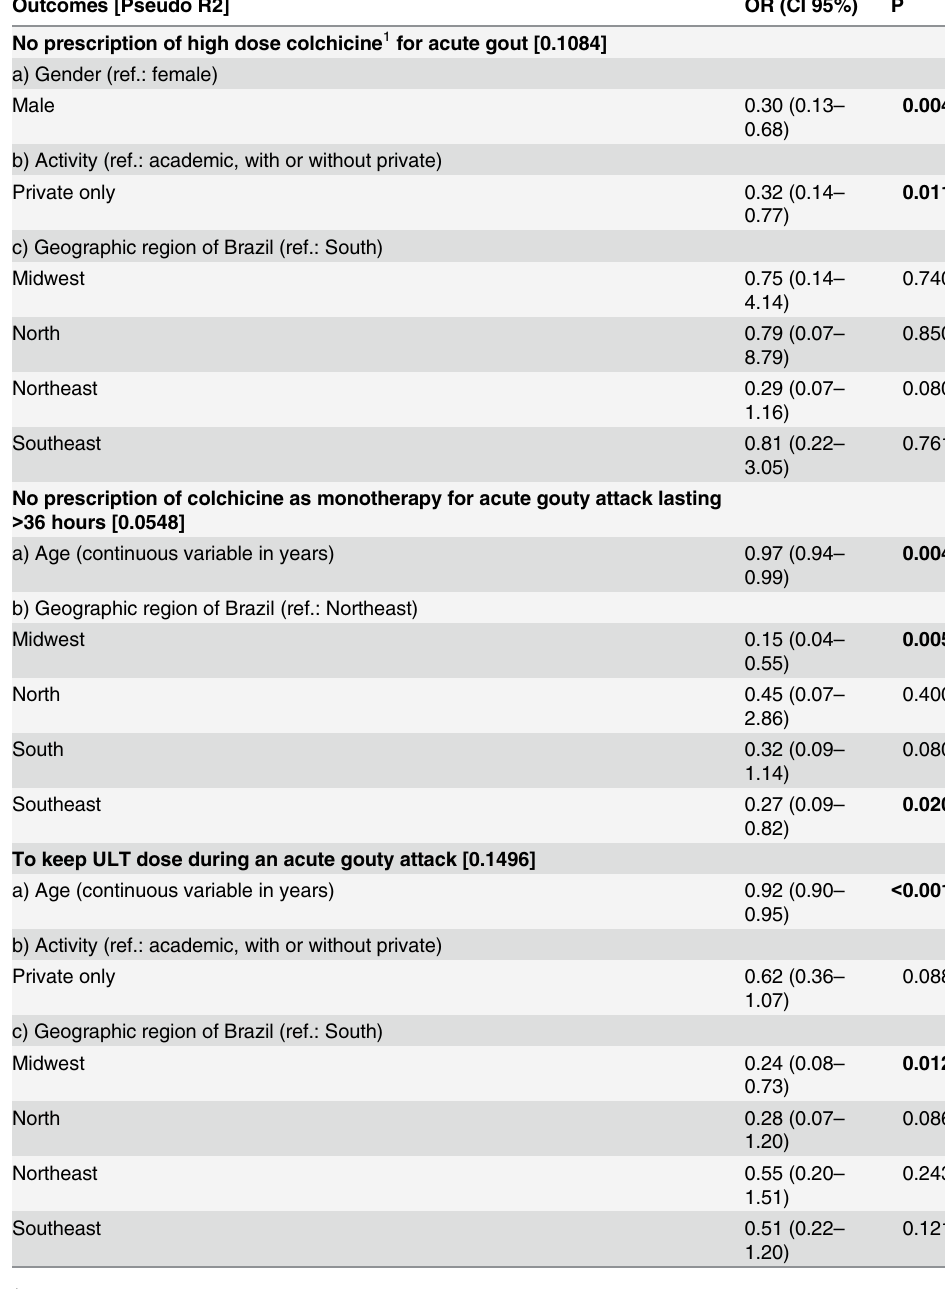
Table 4. Multivariate-adjusted predictors of concordance between reported acute gout management and the 2012 ACR gout guidelines. Outcomes [Pseudo R2] OR (CI 95%)